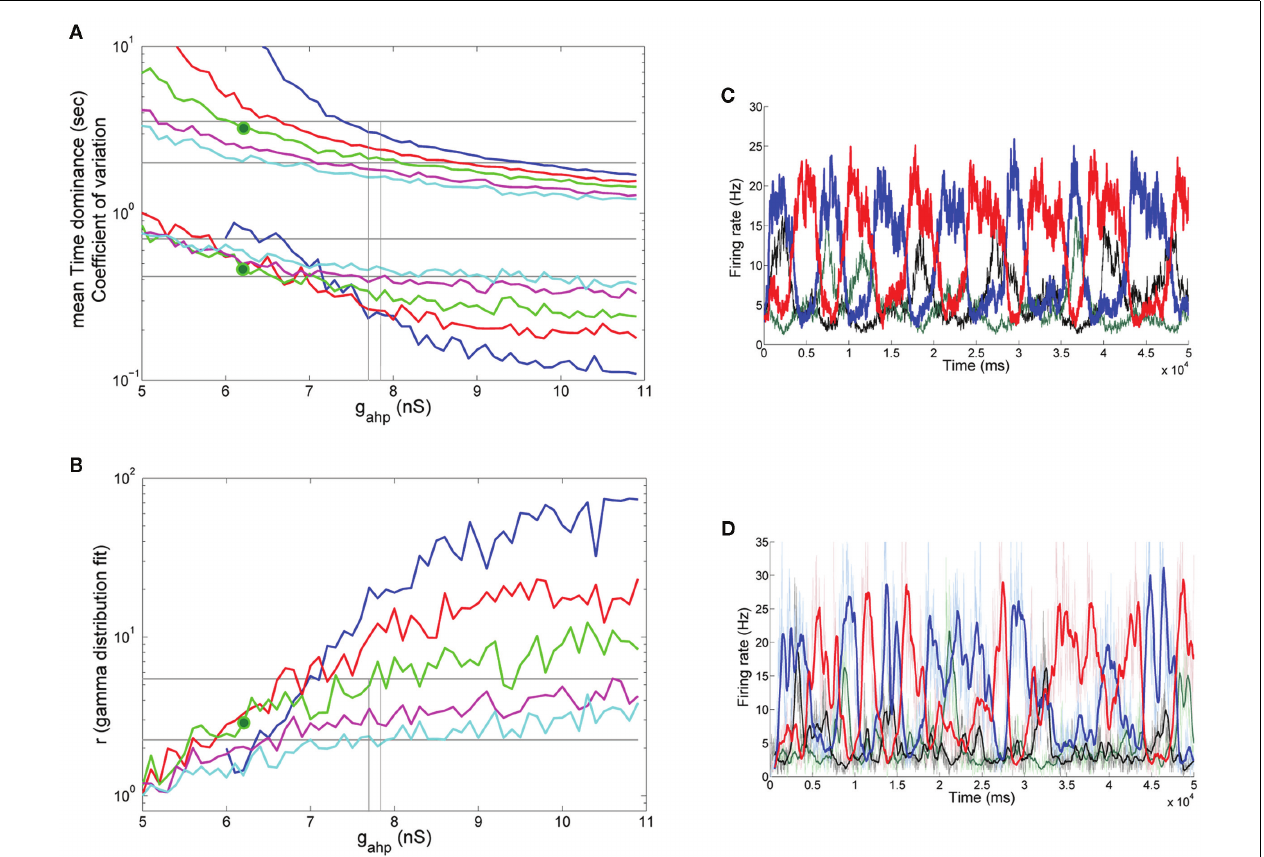
FIGURE 7 | Spike-frequency adaptation to all neurons of the network: Replicating the experimental data (A) Mean time dominance and coefficient of variation as a function of neuronal adaptation for different levels of noise (blue: n = 0.01, red: n = 0.014, green: n = 0.016, magenta: n = 0.018 and celestial: n = 0.019) for λ 1 = λ 2 = 40Hz. (B) Parameter r of gamma distribution fit to the distribution of dominance times as a function of neuronal adaptation for the same noise levels as in (A) . In both (A,B) , horizontal lines denote the range that the experimental data define.Vertical lines are drawn at the bifurcation points where the system transits from a bistable dynamical regime to a mixed-mode oscillations and to an oscillatory regime. Green big circles at the levels g ahp = 6.2nS, n = 0.016 indicate a case